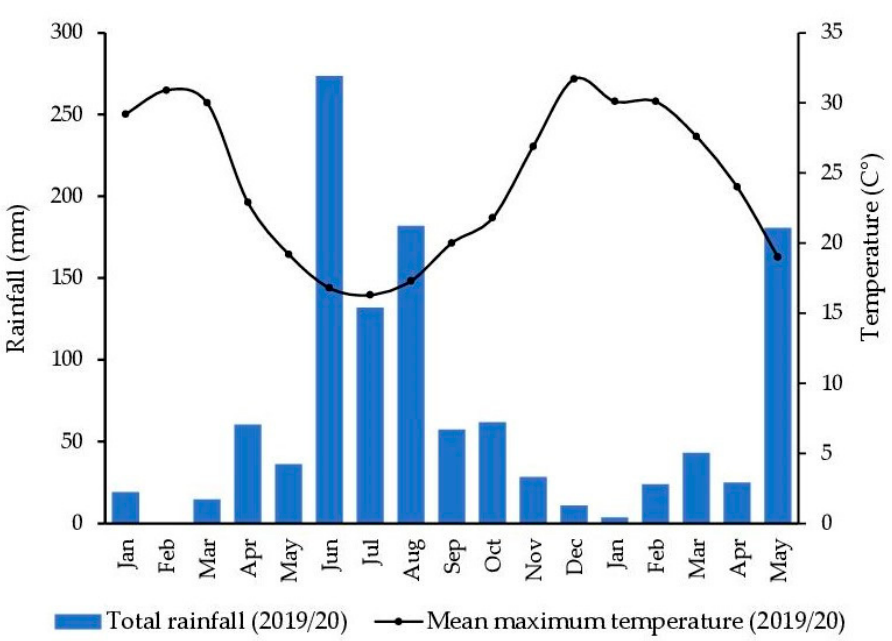
Figure A1. Total monthly rainfall (Bureau of Meteorology Jarrahdale weather station) and mean maximum monthly temperature for the period January 2019 to May 2020 (Bureau of Meteorology Karnet weather station) in the relocation area [62].